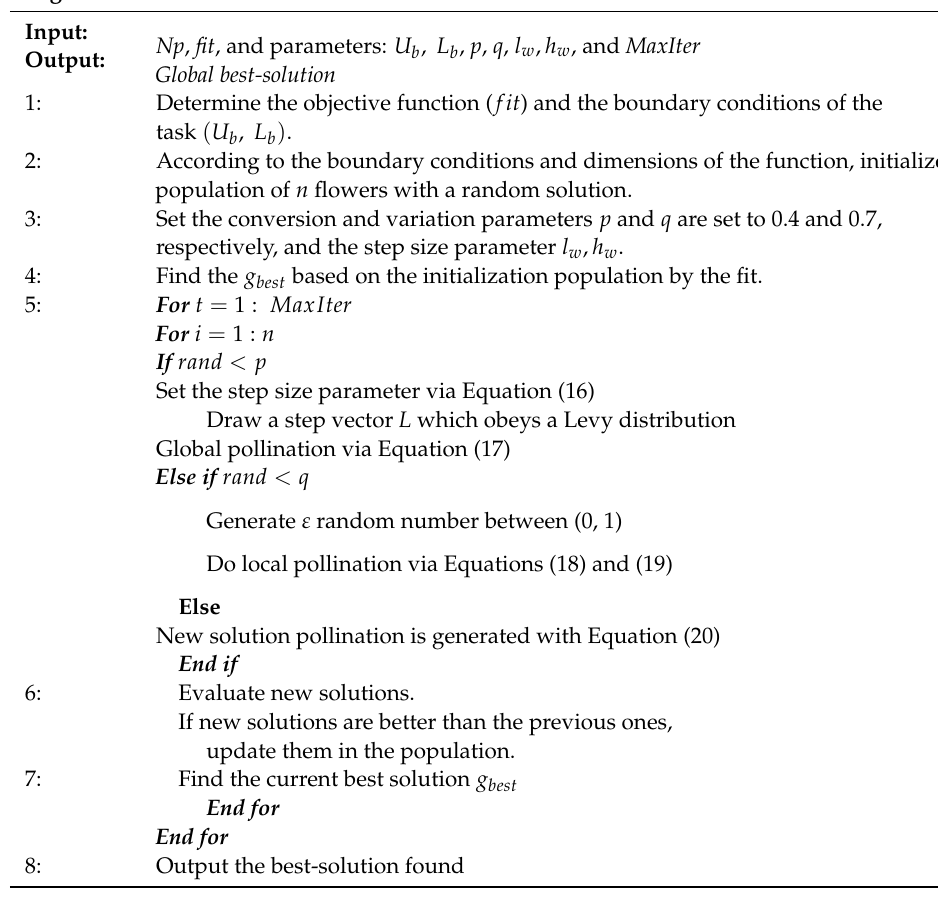
Algorithm 1: Pseudo-code of the HSFPA